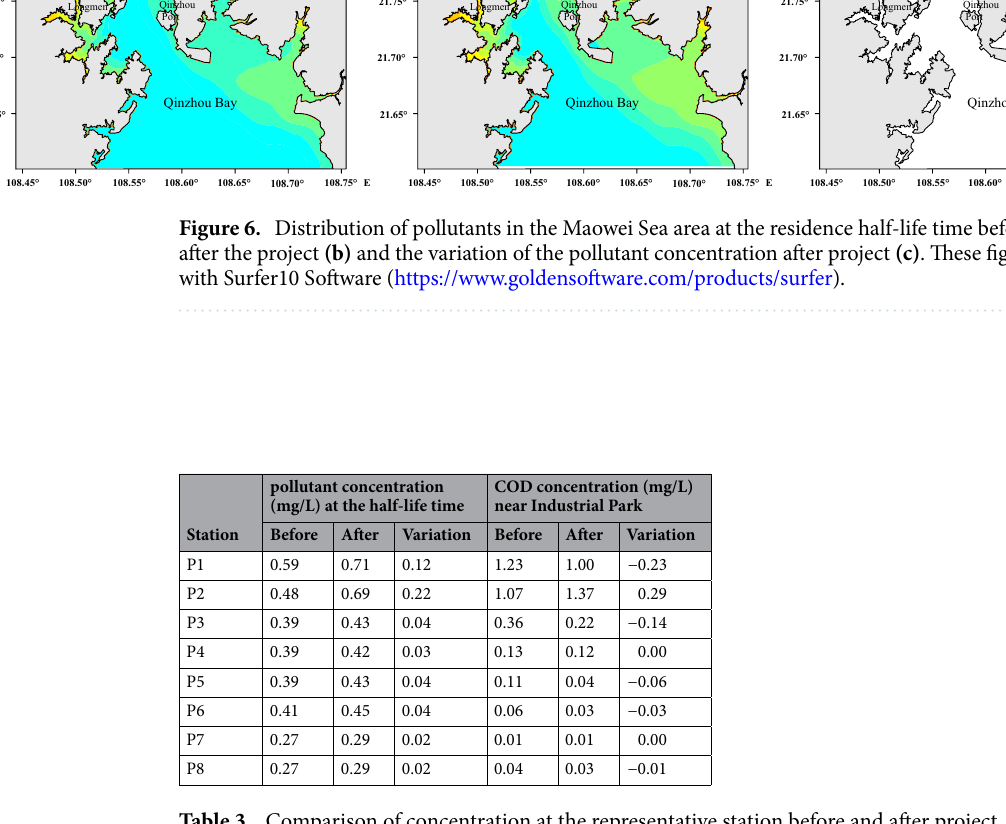
Table 3. Comparison of concentration at the representative station before and after project.